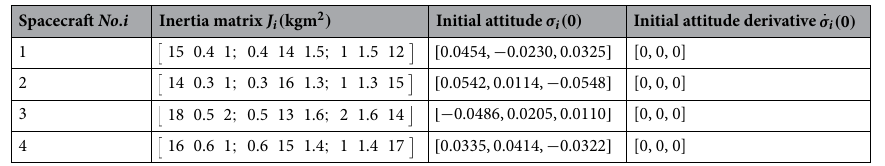
Table 1. Initial parameters of follower spacecraft.